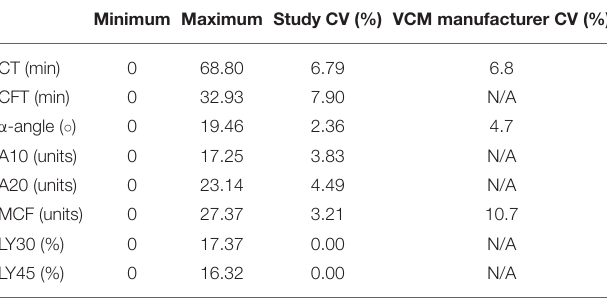
TABLE 3 | Within sample variation (CV, %) listed as a